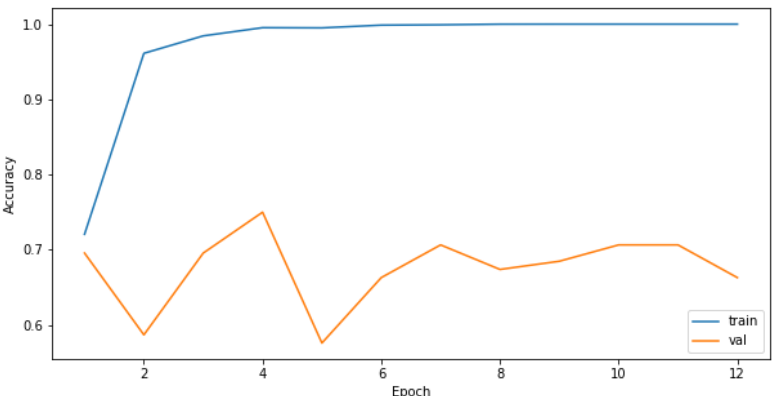
Figure 9. Model accuracy for the model with 1 layer and a batch size of 256 in relation to different number of epochs used to train the